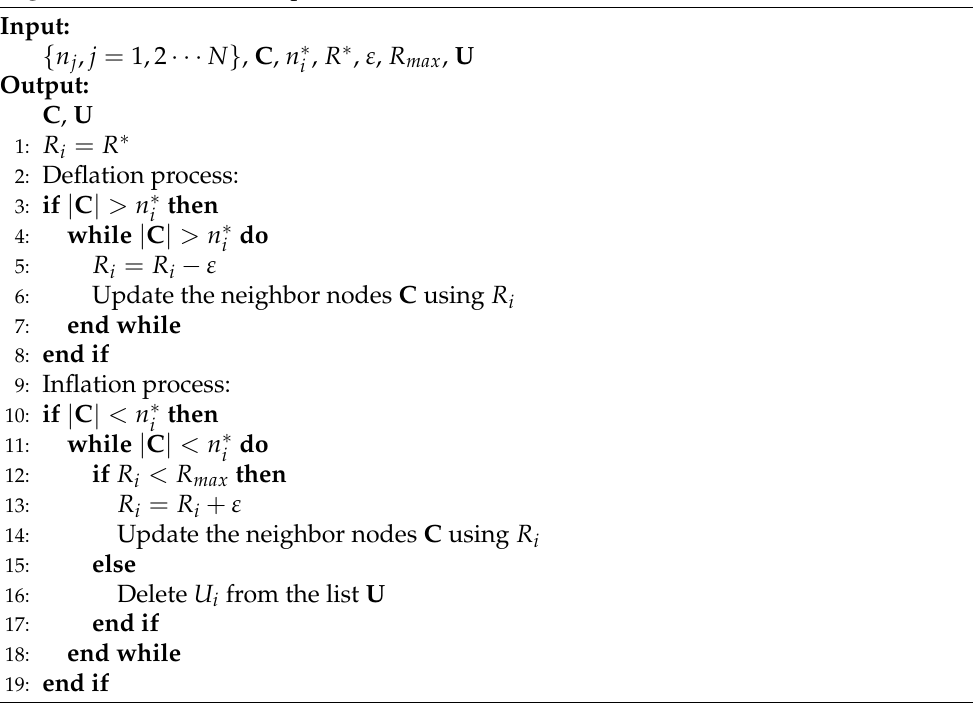
Algorithm 3 Tire inflation